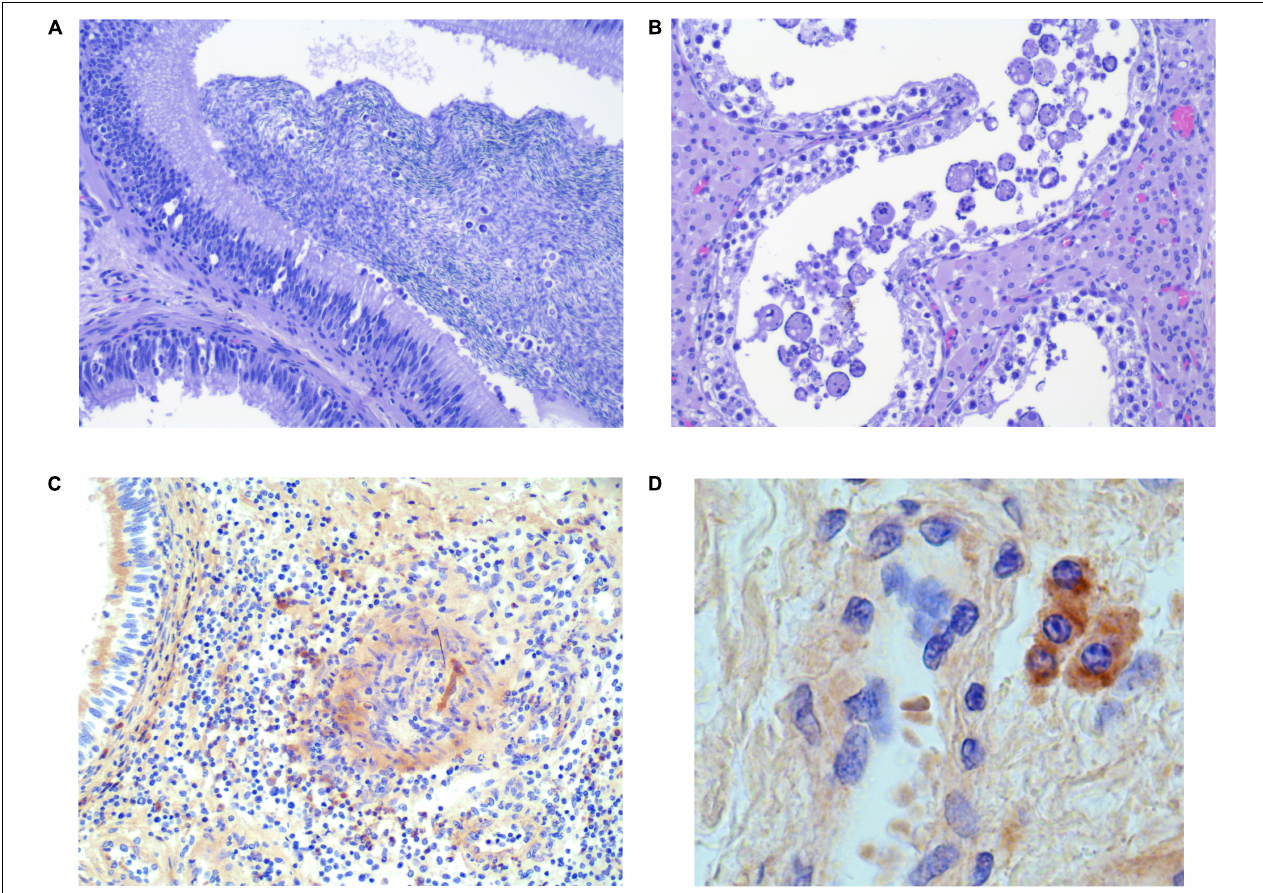
FIGURE 3 | Selected histological sections of testis (B,D) and epididymis (A,C) from PRRSV-1-infected boars, stained with H&E (A,C) and IHC (C,D) . (A) Intraluminal mononuclear cells [infiltrating the epithelium (arrows)]. (B) Intraluminal swollen/enlarged/giant cells. (C) Few focally distributed infected macrophages in the testicular interstitium. (D) Few focally distributed infected macrophages in the interstitium of epididymis (40 ×